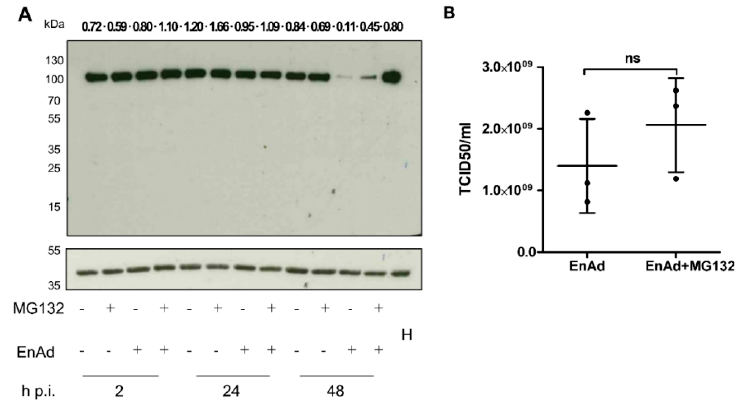
Figure 4. Enadenovirus infection is associated with a partially proteasomally mediated decrease in DNA ligase IV levels. A549 cells were infected with EnAd-SA-GFP at 200 VP/cell (approximately an MOI of 11) or mock-infected. At 2 h post-infection, cells were treated with 10 µM MG132 or DMSO control. ( A ) Cell lysates were harvested either immediately after treatment, 24 h p. i., or 48 h p. i., separated by SDS-PAGE and probed with antibodies against DNA ligase IV or β -actin. Lanes contain